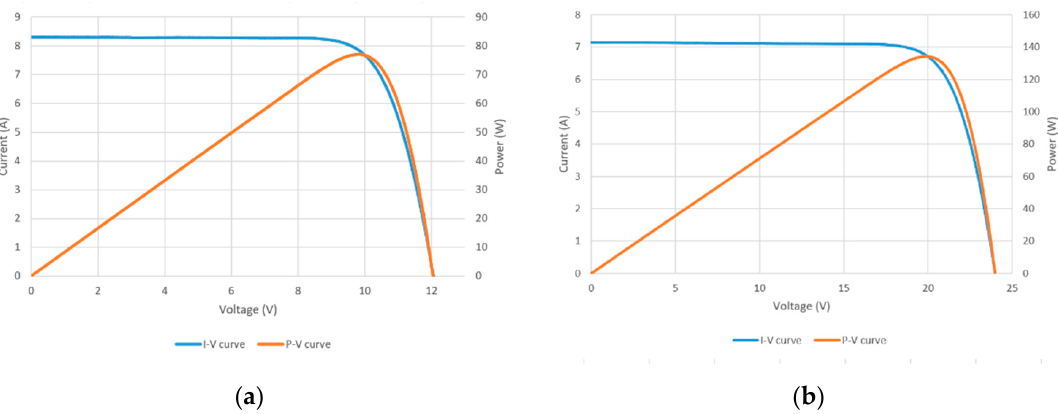
Figure 5. STC performance of PV modules under analysis: ( a ) Suncol ® Tile Terracotta; and ( b ) Suncol ® Tile Texturing Roof tile.